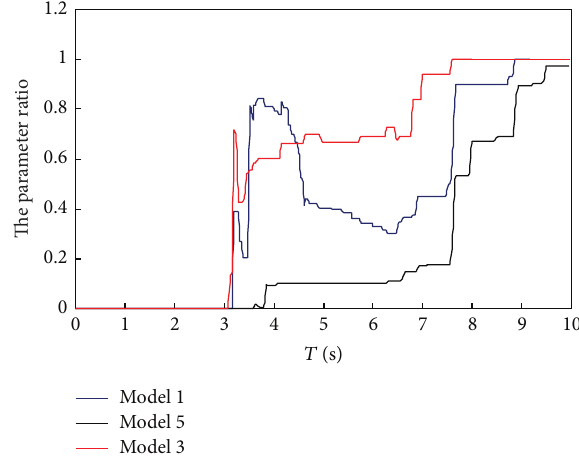
Figure 37: The tension crack damage parameter of pier between windows under Wolong ground motion.